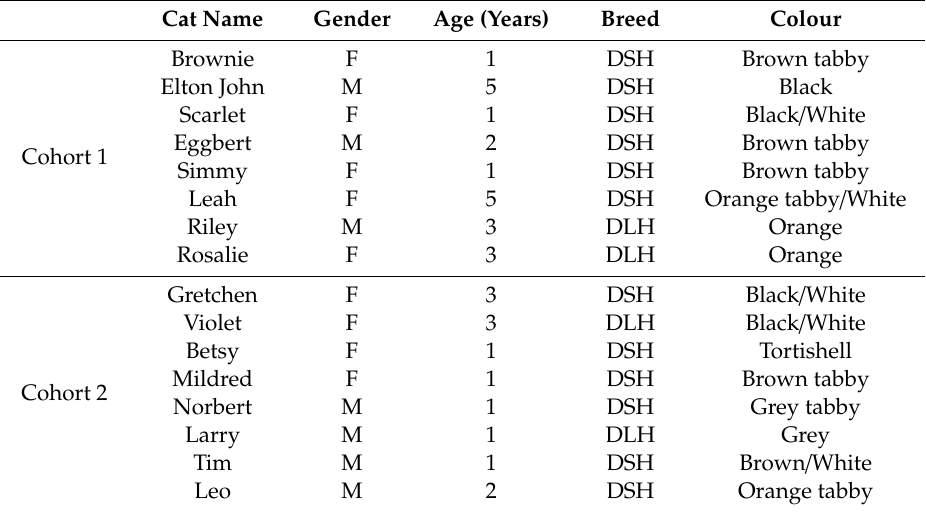
Table 1. Cat demographics by